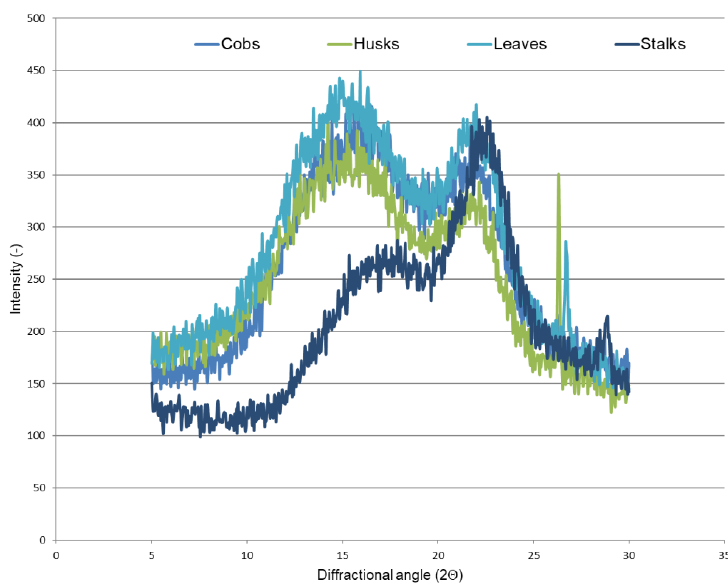
Figure 3. X-ray diffraction patterns of maize stover fractions.